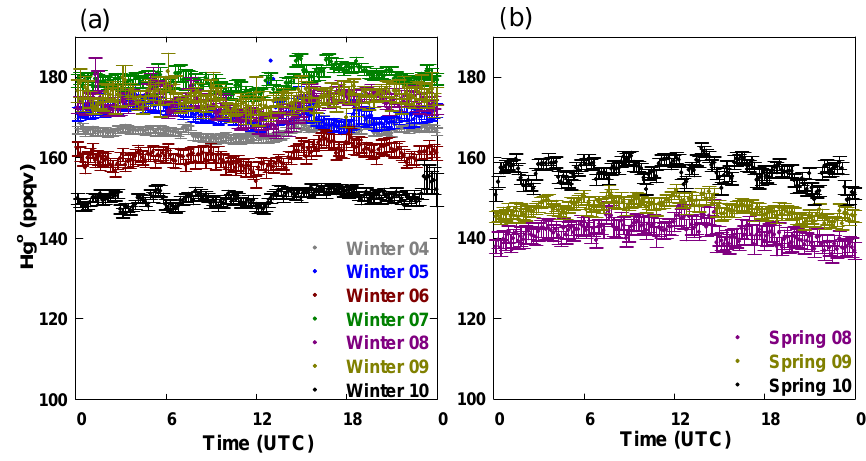
Fig. 7. Seasonally averaged diurnal cycles of Hg 0 with standard deviation of means for summer at TF (a) and AI (b) Figure 7: Seasonally averaged diurnal cycles of Hg ° with standard deviation of means at TF (a) and AI (b).